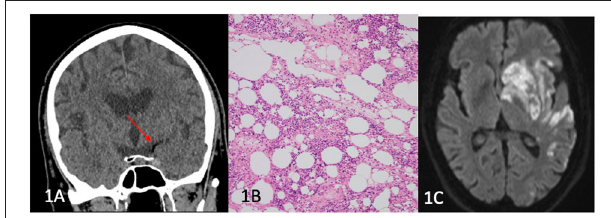
FIGURE 1 | (A) Left hypodense M1 artery (red arrow), (B) histopathology showing bone marrow constituents and adipose tissue consistent with fat embolism, (C) Diffusion weighted imaging (DWI) showing left MCA territory infarction.